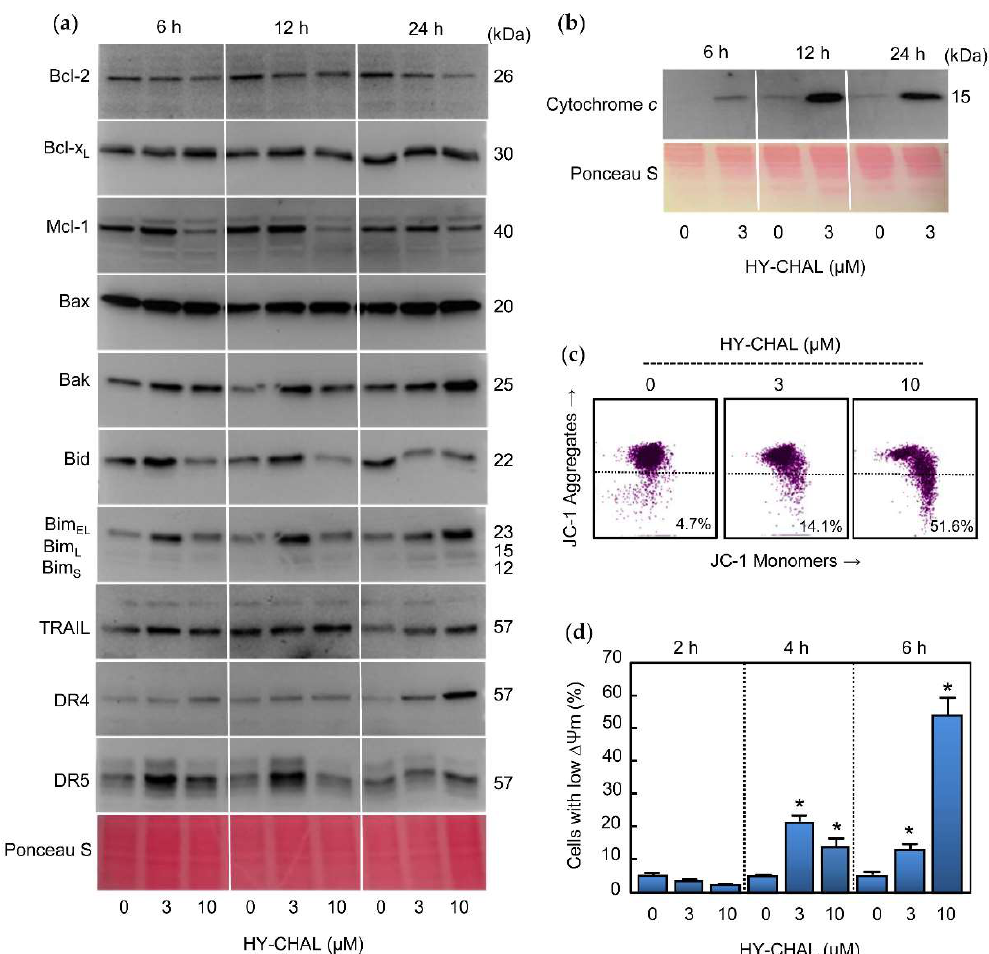
Figure 4. Role of the mitochondria, TRAIL and Death Receptors in the apoptotic cell death triggered by HY-CHAL in SK-MEL-1 melanoma cells. ( a ) Cells were treated with the specified concentrations of HY-CHAL for the indicated times and whole cell lysates were probed with antibodies raised against the indicated Bcl-2 family proteins, TRAIL, and death receptors by immunoblotting. Equal protein loading was controlled by staining the membranes with Ponceau S before the incubation with antibodies (a representative section of the stained membrane is shown); ( b ) Cells were treated with 3 µM HY-CHAL for the indicated times and cytosolic fractions prepared, separated by SDS-PAGE and cytochrome c was detected by immunoblotting. Equal protein loading was controlled by staining the membranes with Ponceau S; ( c ) Cells were incubated with the indicated concentrations of HY-CHAL for 6 h and ΔΨ m analyzed by flow cytometry after staining with the JC-1 probe as described in the Experimental Section; ( d ) Cells were incubated in control conditions or in the presence of the indicated concentrations of HY-CHAL for the specified times, and the percentage of cells with reduced ΔΨ m was quantified by flow cytometry using the fluorescent probe JC-1. * Indicates p < 0.05 for comparison with untreated control.